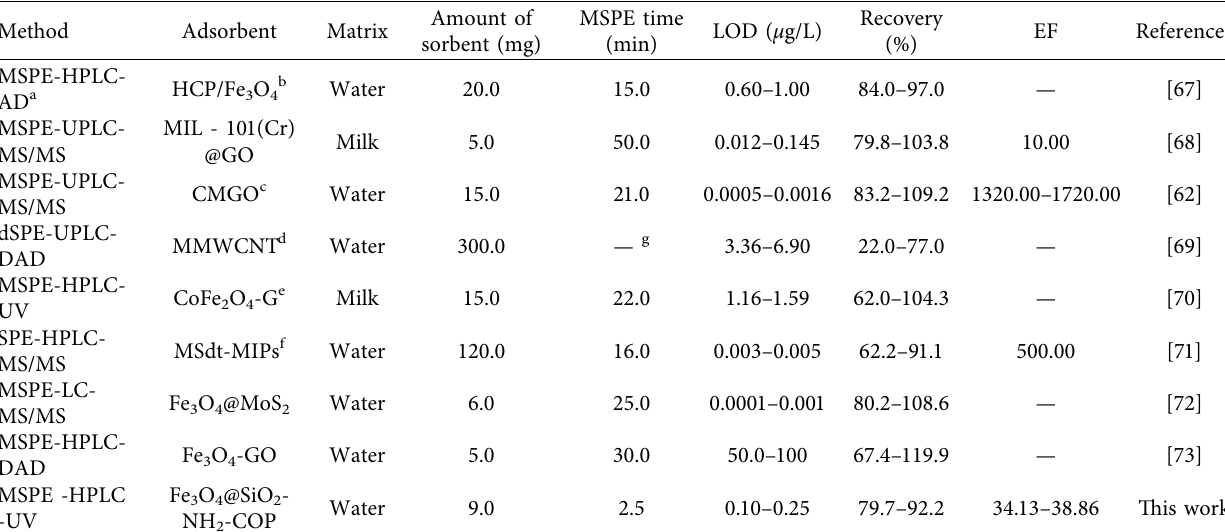
Table 6: A comparison of various methods for the determination of